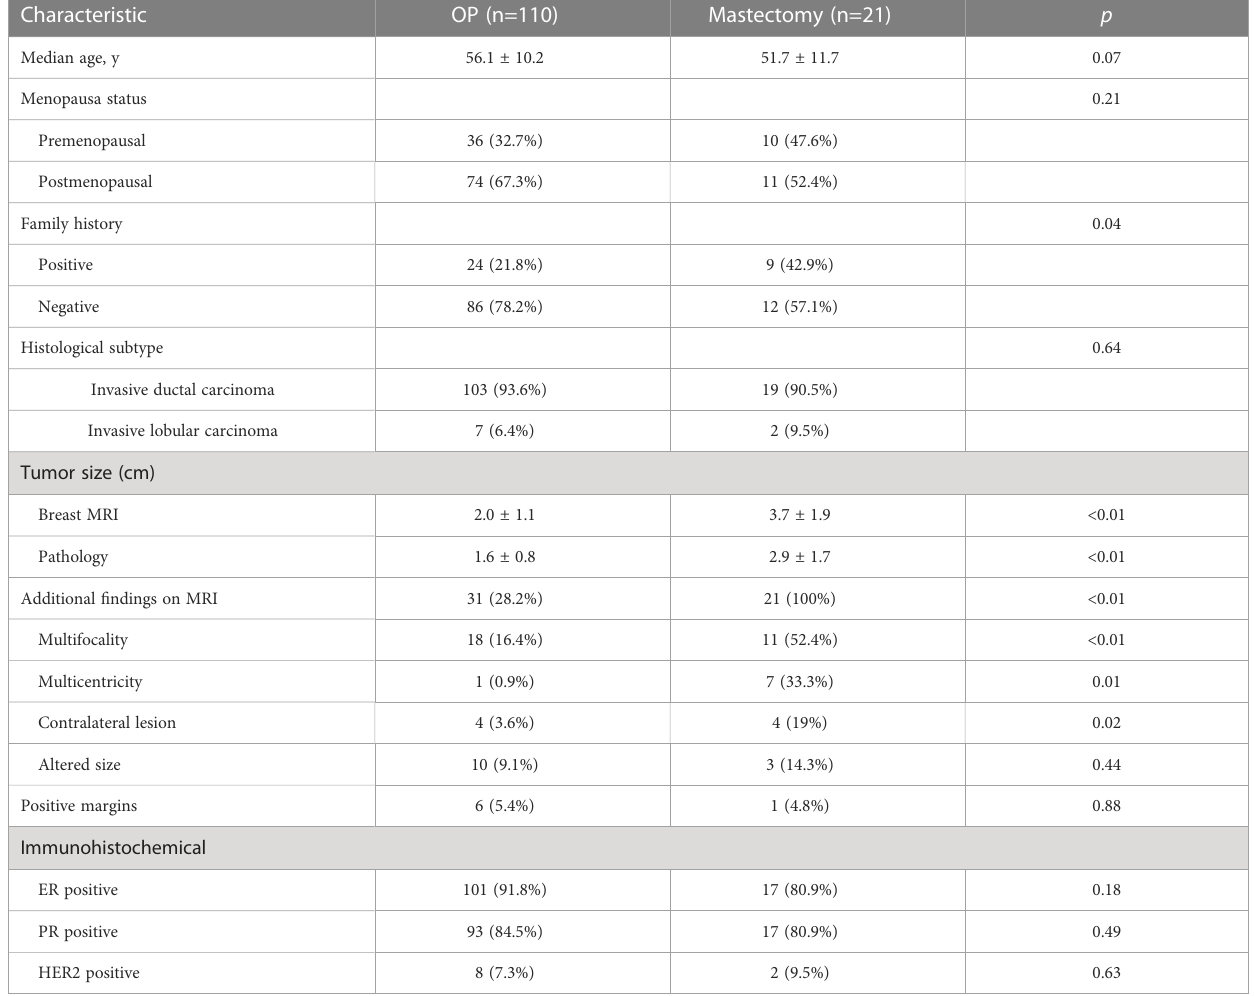
TABLE 3 Clinical, imaging and pathological features of patients submitted to OP or